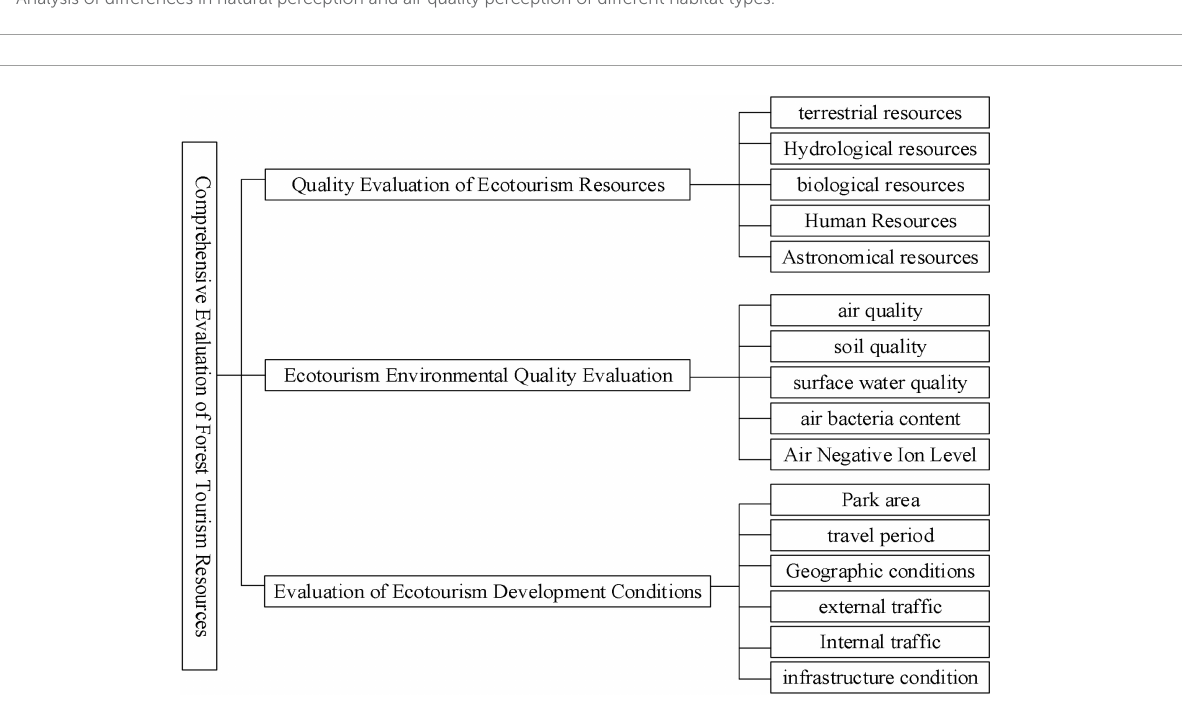
FIGURE3 Evaluation framework of ecotourism